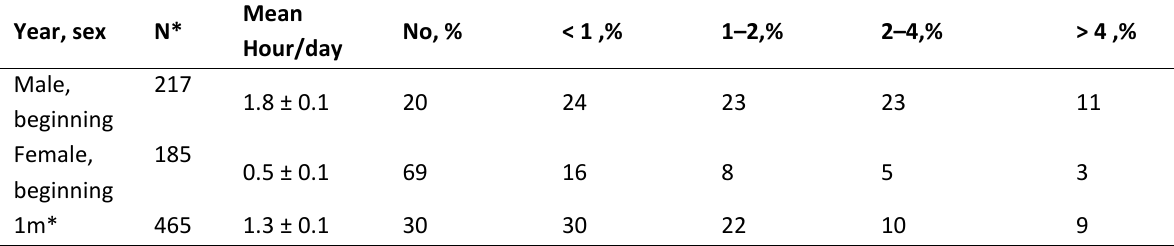
Table 1. Distribution of students by time losses (hour/day), connected with computer games Year,